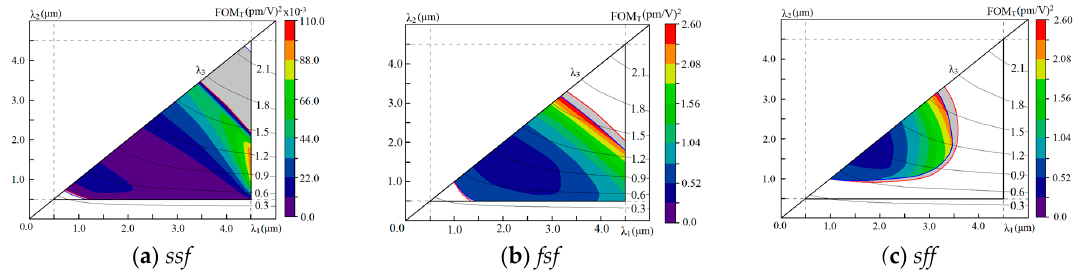
Figure 12. FOM T ( λ 1 , λ 2 ) distributions for KTP crystal for all types of interactions: ( a ) ssf , ( b ) fsf , ( c ) sff .